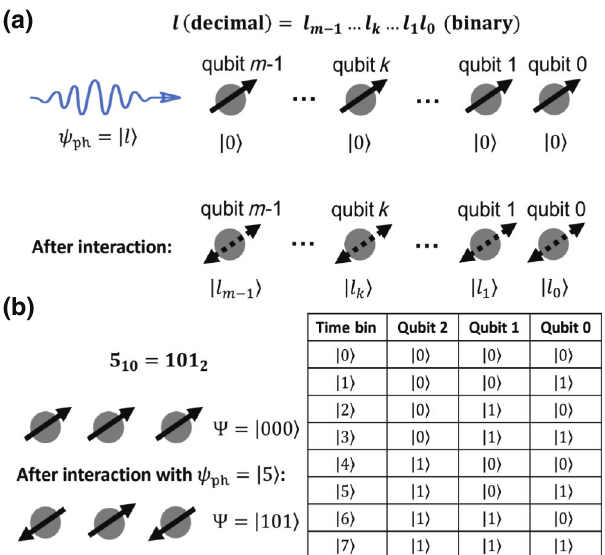
FIG. 2. (a) The interaction between the photonic qudit and an m -qubit register. The m -qubit register is initialized at | 0 (cid:2) ⊗ m . If the photonic qudit is in state | l (cid:2) ( l = 0, 1, . . . , 2 m − 1) and the decimal value of l can be represented in binary [ l ] 10 = [ l m − 1 · · · l k · · · l 1 l 0 ] 2 , the photonic qudit will flip the n -qudit reg- ister to state | l m − 1 · · · l k · · · l 1 l 0 (cid:2) . (b) An example for a photonic state | 5 (cid:2) and a three-qubit register with a value table given for the m = 3